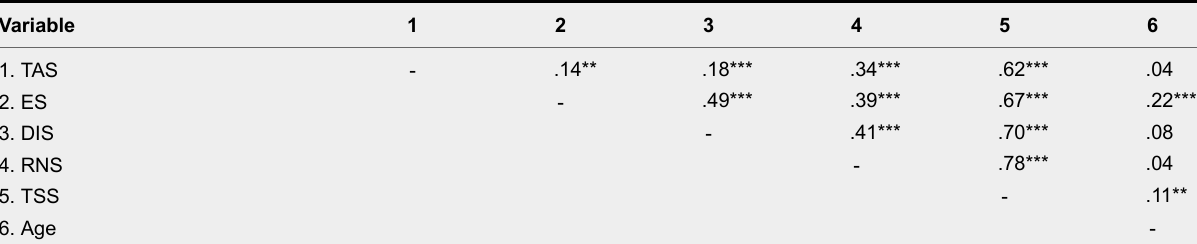
Spearman Correlations Among Subscales and Correlations With Age